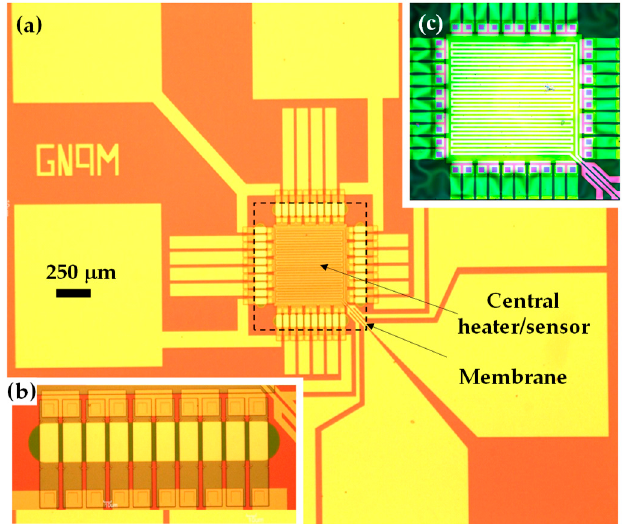
Figure 1. ( a ) Micrograph of the front of the thermoelectric generator (TEG) being tested, indicating the membrane area and the central heater/sensor Au grid locations. ( b ) Detail of the thin film strips that conform to the 5 n-p thermocouples that were found in each side of the squared membrane. ( c ) Image of the free-standing membrane take from the back.